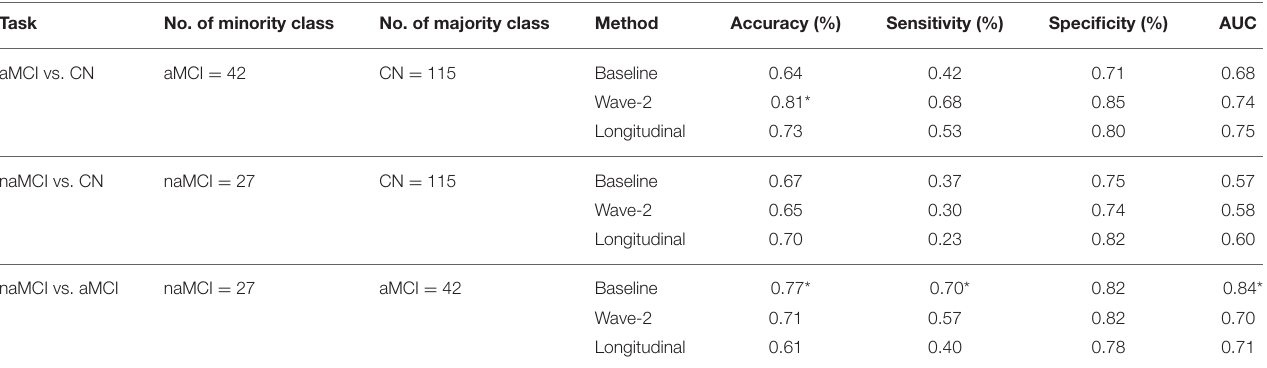
TABLE 2 | Classification results of MCI subtypes: features measured at baseline, wave-2 and longitudinally are used and compared.